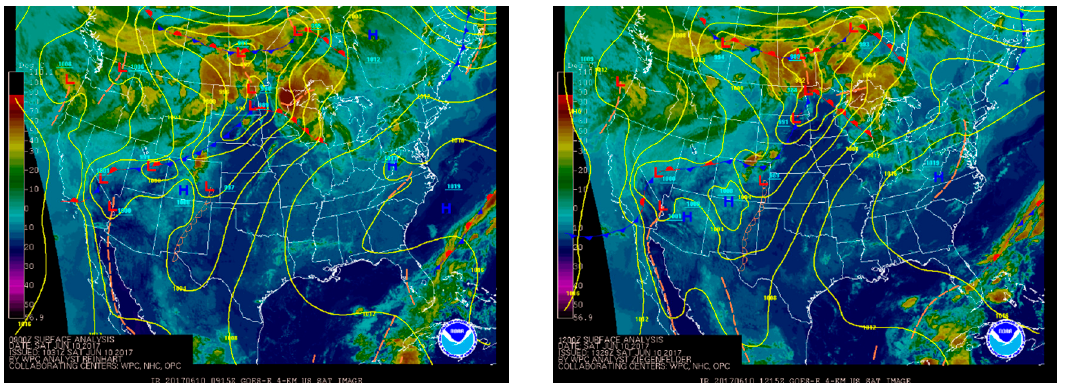
Figure 11. Satellite composite map of 10 June, with 09Z ( left ) and 12Z ( right ) showing the arrival and passage of a dryline through ELP region. Source: National Weather Service’s (NWS) Weather Prediction Center (WPC) Surface Analysis Archive.